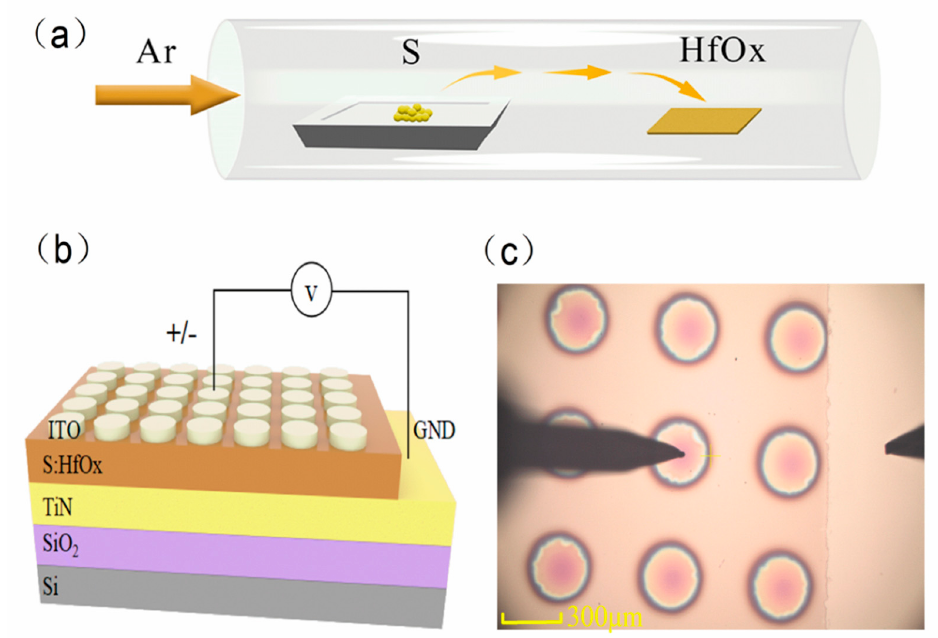
Figure 1. ( a ) Schematic diagram of two-temperature zone tube furnace. ( b ) Structure of TiN/S:HfOx/ITO for the S-doped device (The left probe contacts the ITO electrode and the right probe contacts GND). ( c ) Optical micrograph of the device.